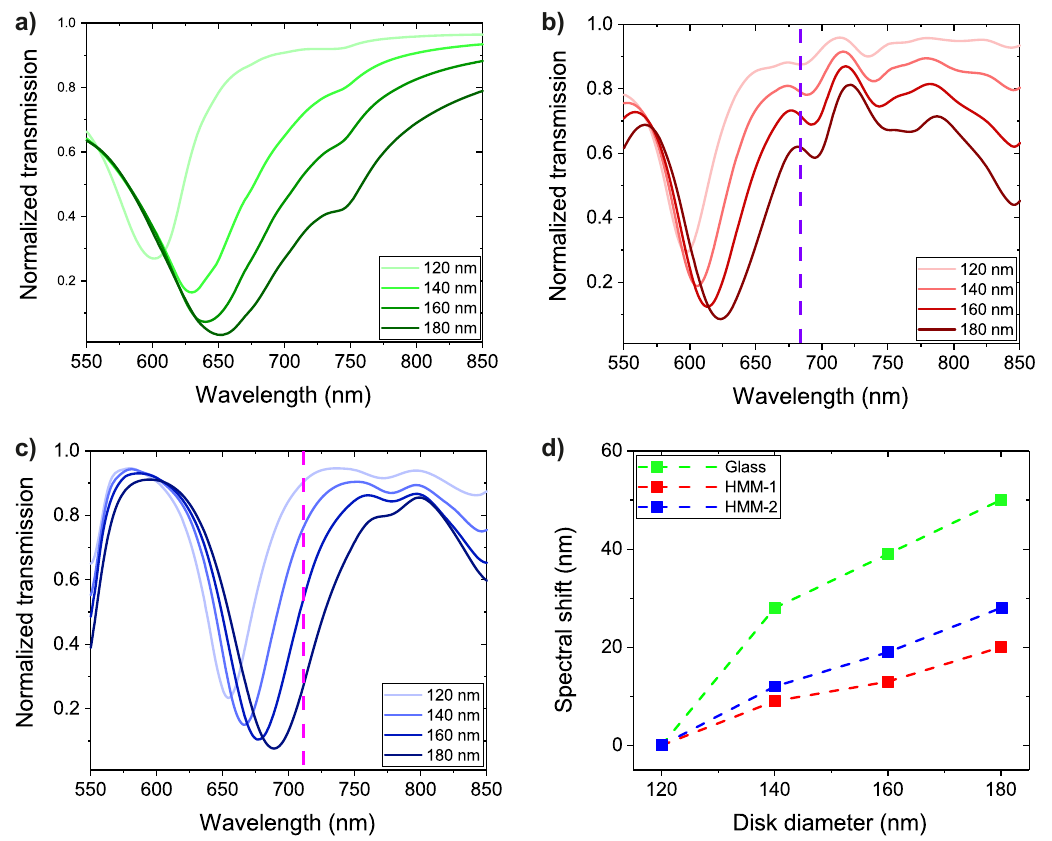
Figure 2: Evolution of the plasmon resonance with varying diameters of NDs on (a) glass (b) HMM-1, (c) HMM-2, and (d) spectral shift of the resonance, calculated by FDTD simulations. FDTD, finite-difference time-domain; HMM, hyperbolic metamaterial; ND,